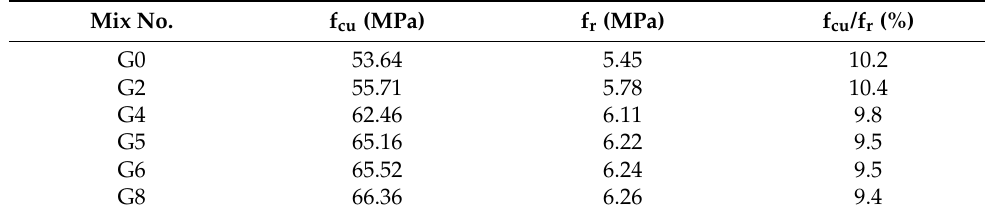
Table 7. Ratio of flexural strength to compressive strength of concrete at an age of 28 days. Mix No.